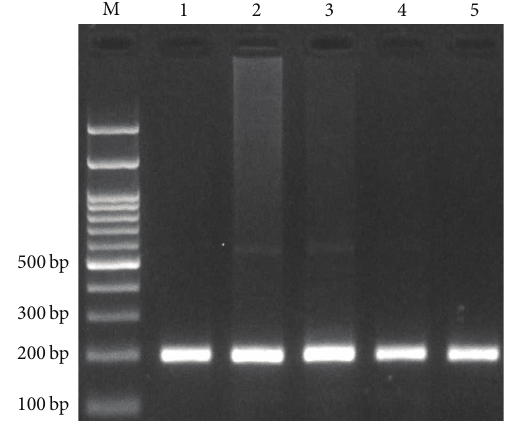
Figure 4: Electrophoresis pattern of PCR for detection of IFNGR1 rs137854905 (27-bp I/D) polymorphism. I allele produces 223 bp while D allele produces 196 bp. M: DNA marker; lanes 1, 2, 3, 4, and 5: DD.